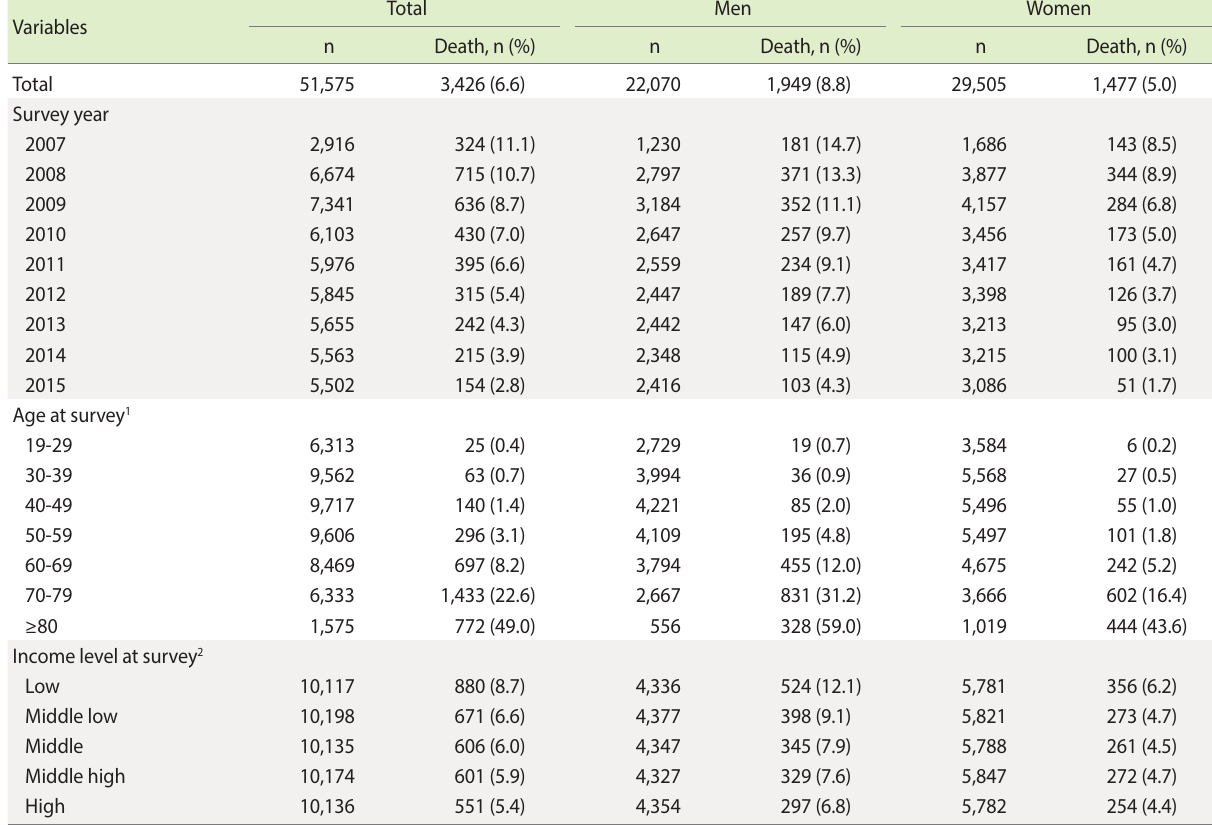
Table 3. Number and percentage of deaths among adults aged 19 years and over in the Korea National Health and Nutrition Examination Survey linked to Cause of Death data (dataset version